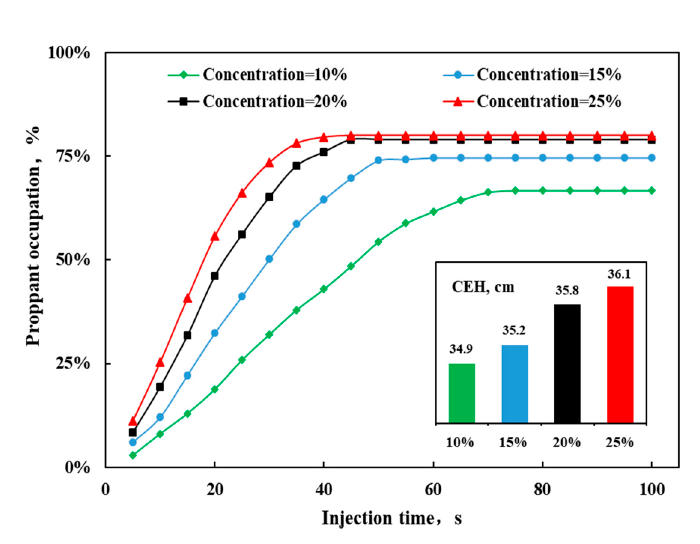
Figure 15. The curve for proppant occupation percentage in fracture change with time and CEH for different inlet position cases.